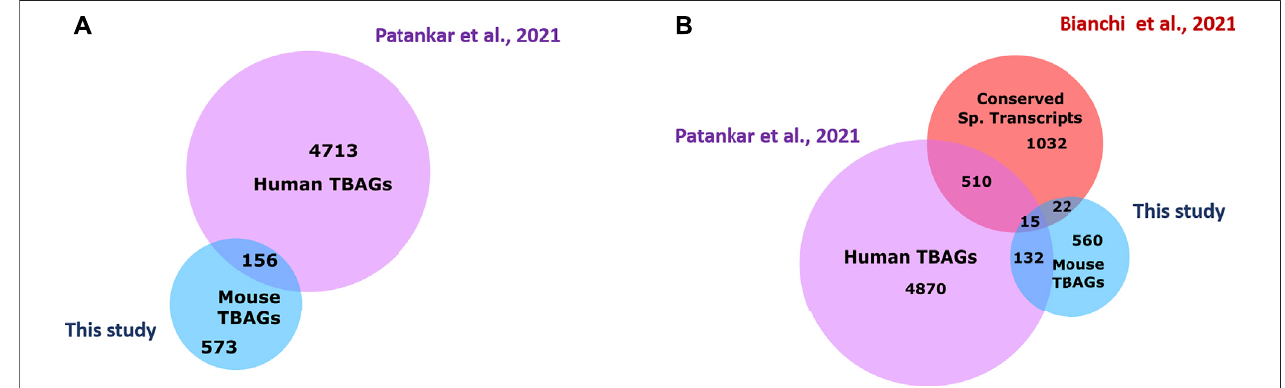
FIGURE 9 | Comparison of human- and murine sperm-retained TH2B. (A) Venn diagram focusing on the common and unique genes between the human and murine TH2B orthologs. (B) Conserved sperm transcripts common to human and mouse TH2B-associated genes (TBAGs).